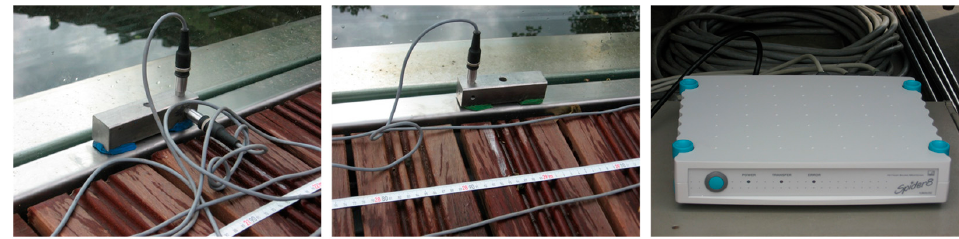
Figure 20. Measurement devices (HBM GmbH accelerometers and amplifier).